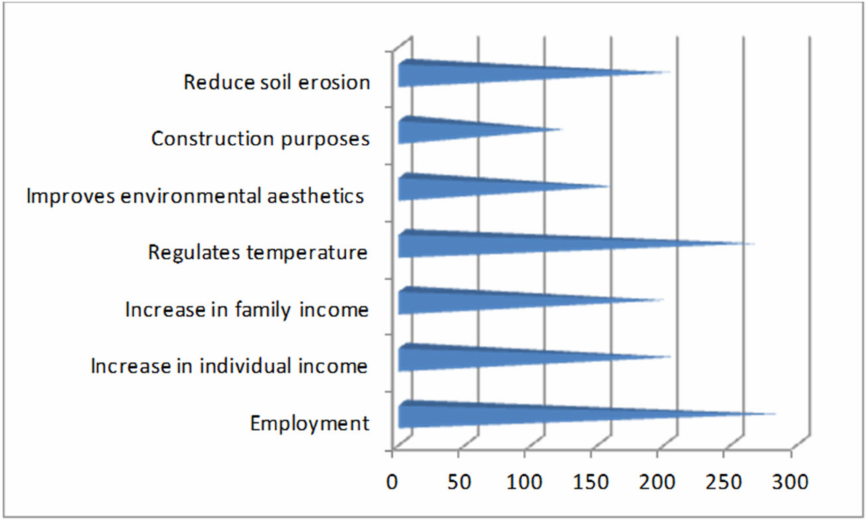
Figure 5. Pattern of benefits from forestry in the region (2019). Source: author’s field survey,